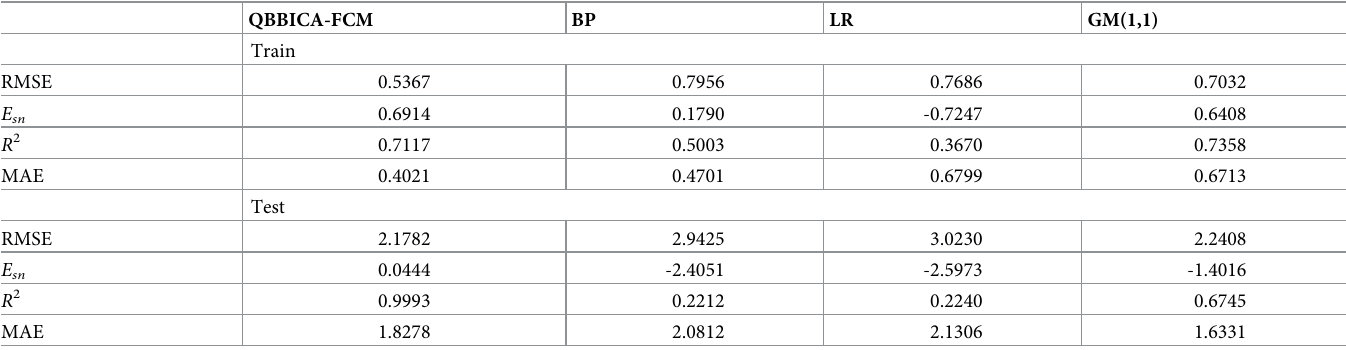
Table 11. Performance comparison of QBBICA-FCM and BP, LR and GM(1,1). QBBICA-FCM